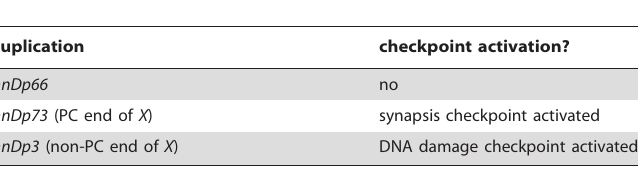
Table 1. Duplications used in this